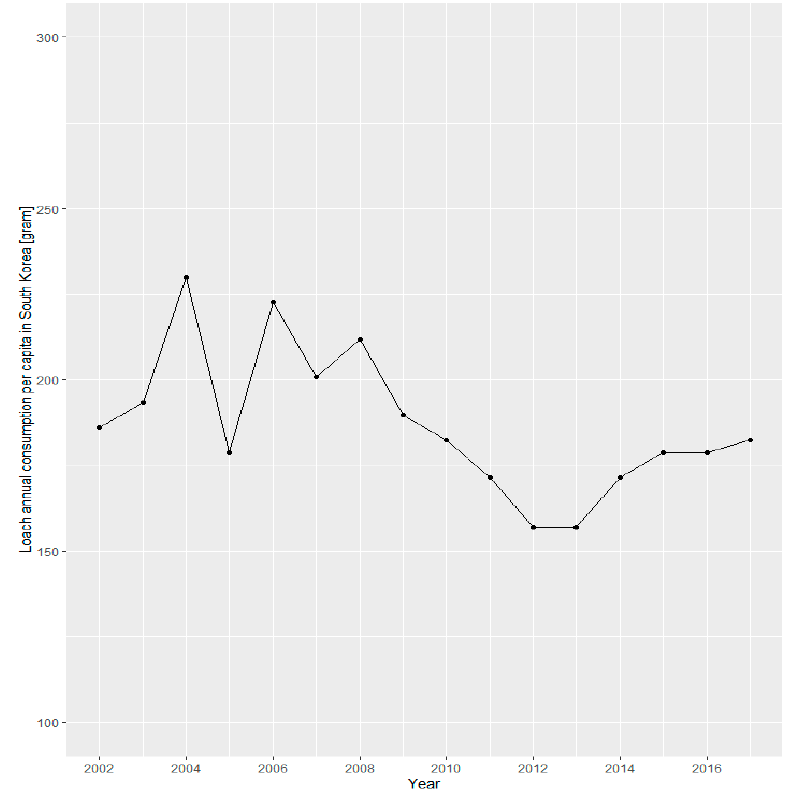
Figure A4. Trend of loach consumption per capita (unit: gram); Source: Korea Rural Economy Institute [50]; 2017 Food Balance Sheet.